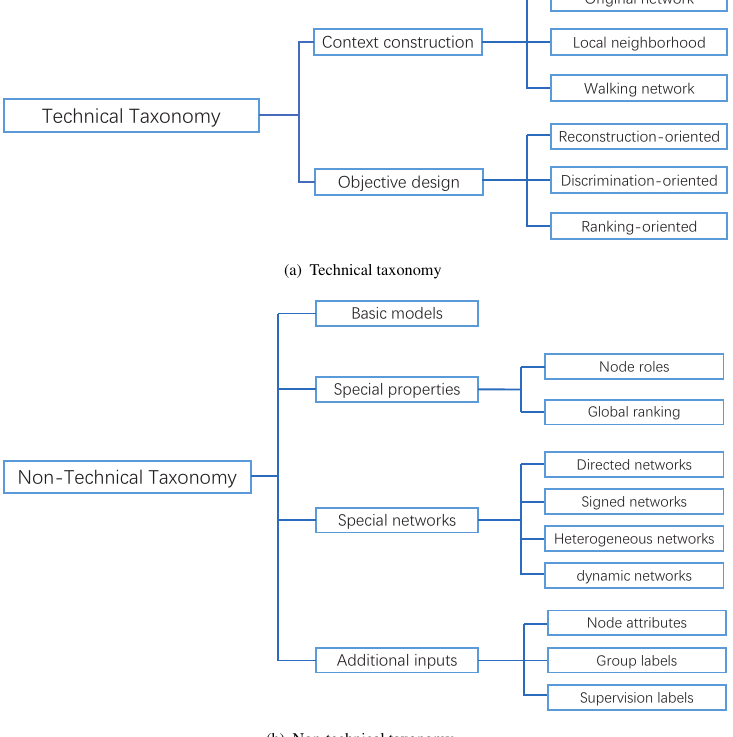
Fig. 1 The proposed two